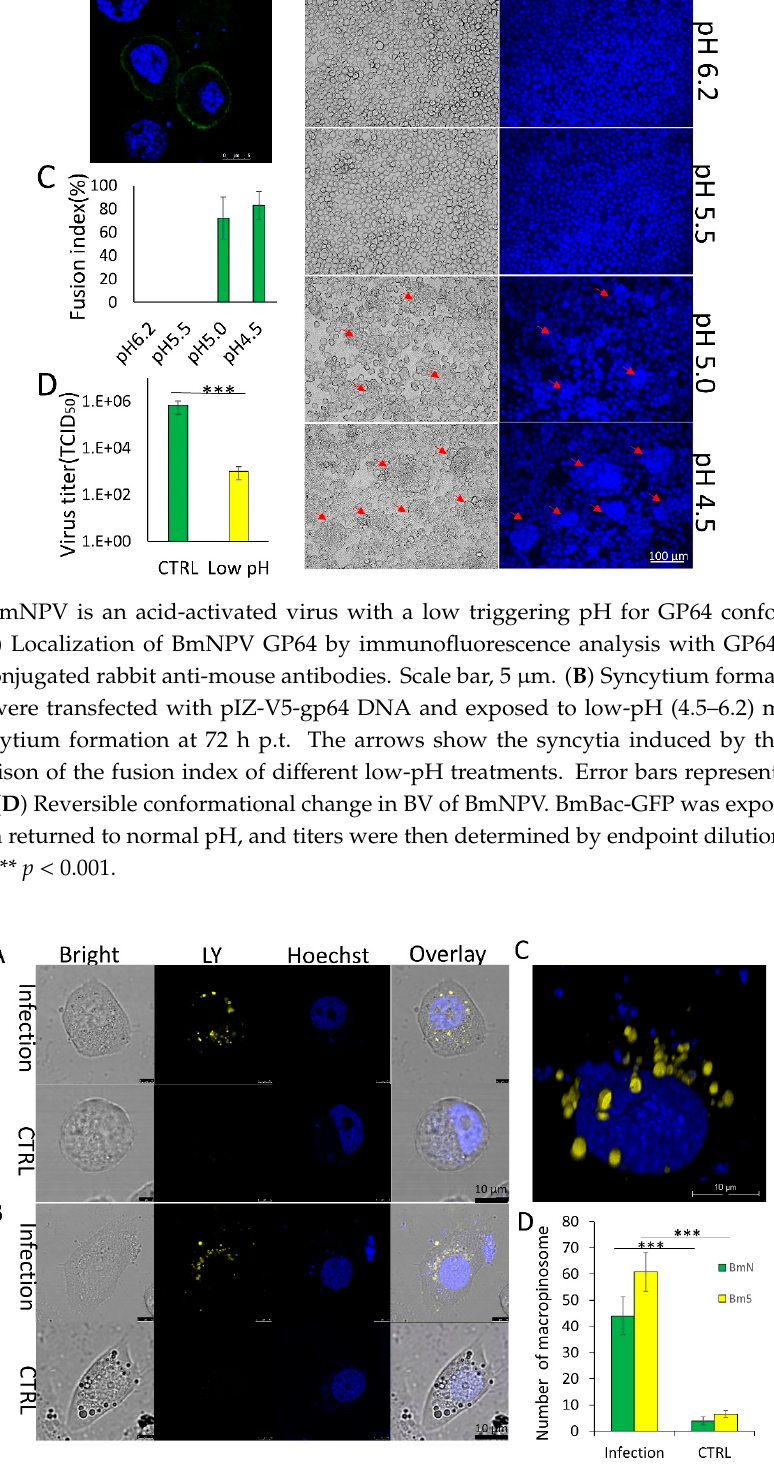
Figure 2. Fluid uptake assay of BV entry into host cells. The fluid uptake levels in BmN (A) and Bm5 (B) cells activated by BmBac-GFP infection at 30 min p.i. Scale bar, 10 μ m. (C) Comparison of macropinosome numbers in BmN and Bm5 cells. Error bars represent standard deviations. *** p < 0.001. ( D ) Reconstruction of 3D scanning for macropinosomes in BmN cells. Scale bar, 10 µ